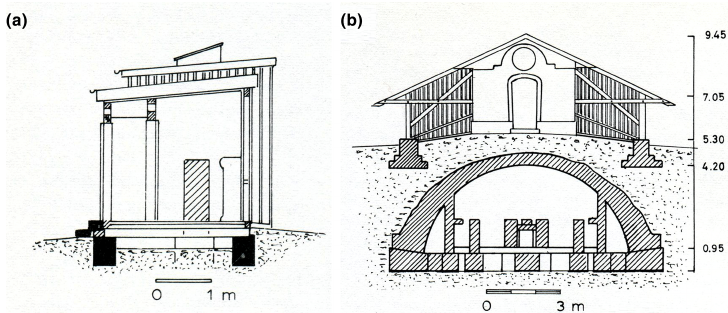
Figure 9. New buildings for the Geomagnetic Observatory on the site of the Astronomical Observatory (see also Fig. 10). (a) Building for absolute measurements. It was established in 1859 and restored in 1898. (b) New partially subsurface building from 1898 for the measurement of the temporal variations. Both laboratories were equipped with new